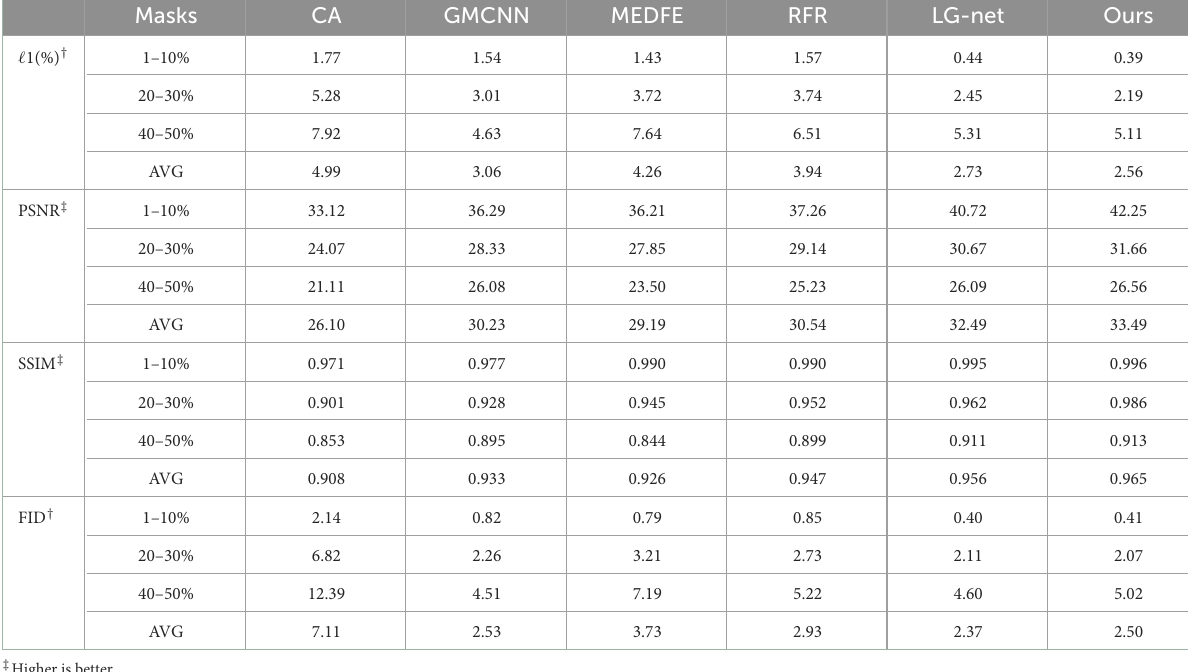
TABLE 1 Quantitative comparisons of ours with the other six methods in CelebA. Masks